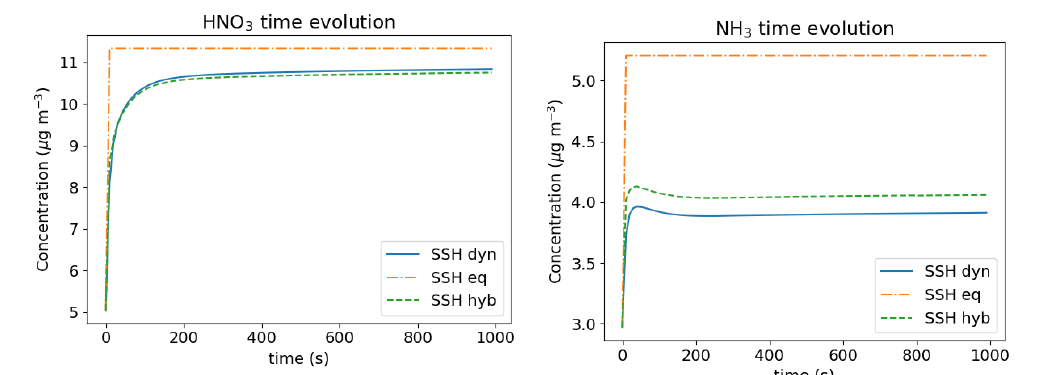
Figure 4. Condensation/evaporation of inorganic test case. Time evolution of HNO 3 concentrations ( left ) and NH 3 concentrations ( right ).